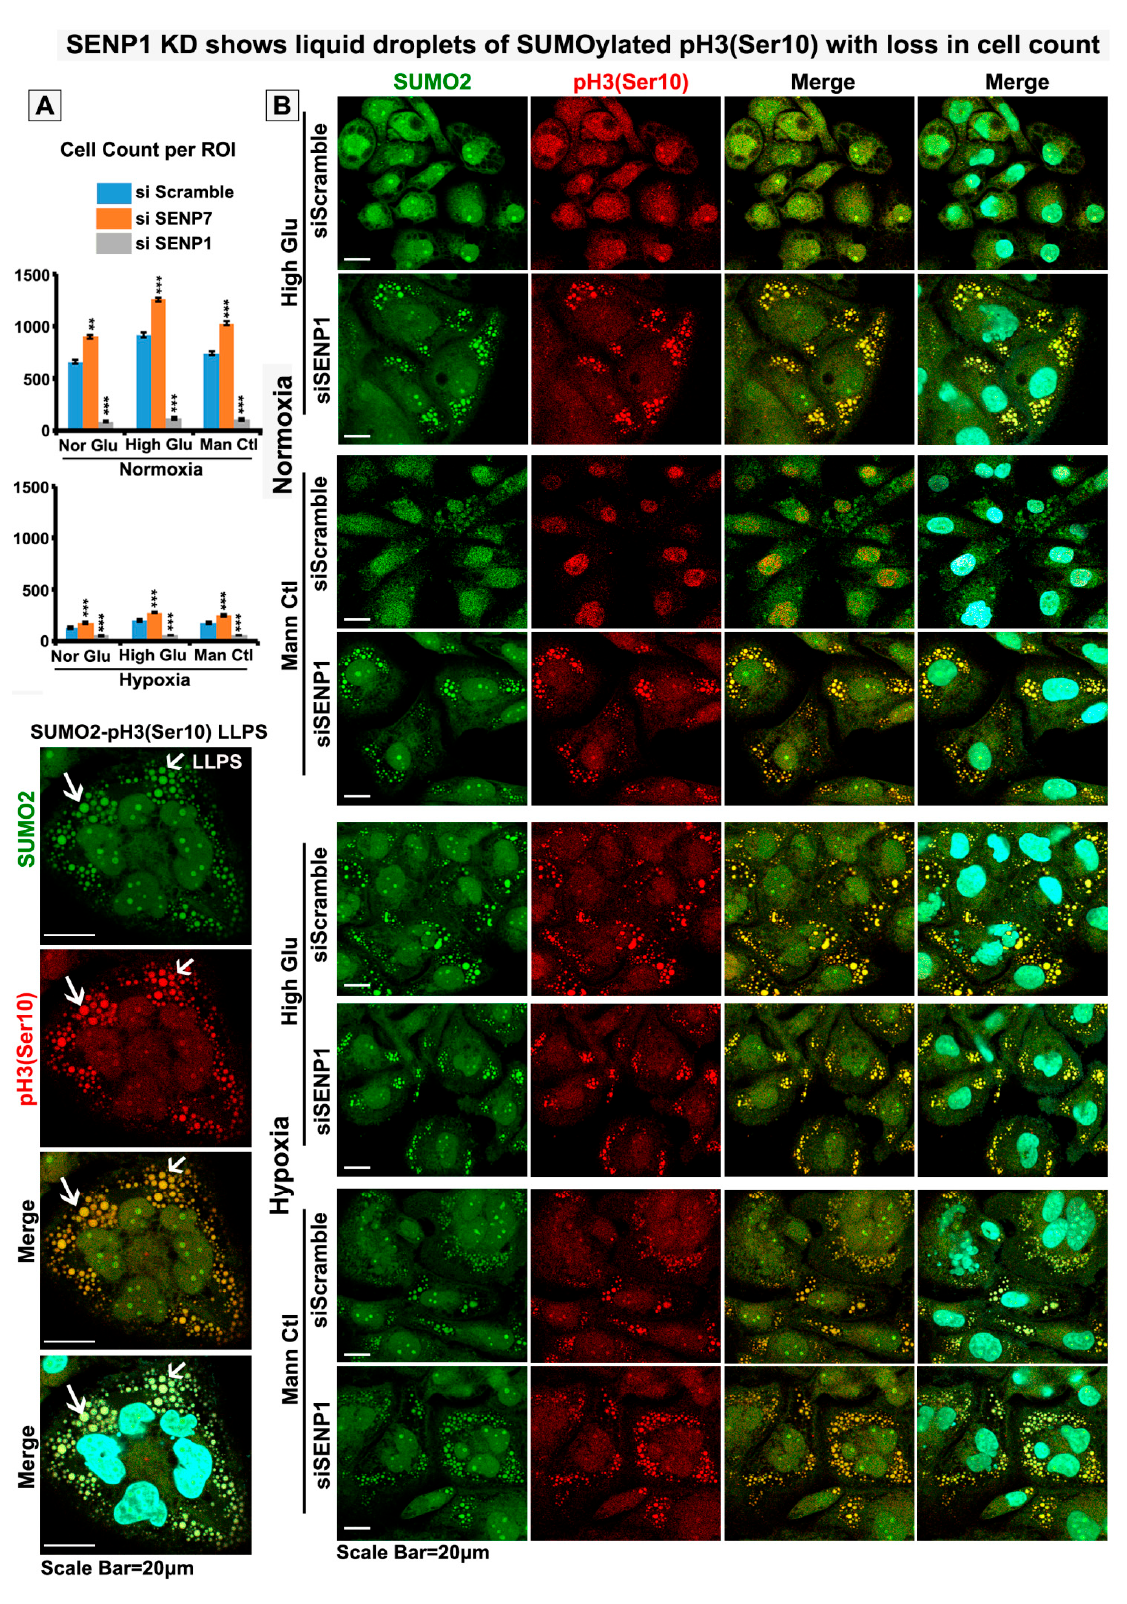
Figure 10. siRNA-mediated knockdown of SENP1 and SENP7 reveals their opposite roles in SUMOylated pH3(Ser10) LLPS formation and tumour cell loss. SENP1 and SENP7 were downregulated independently by the siRNA technique. Post downregulation, tumour cells were subjected to basic treatment conditions for 96 h. ( A ) Cell count was measured in Fiji image analysis software. ( B )